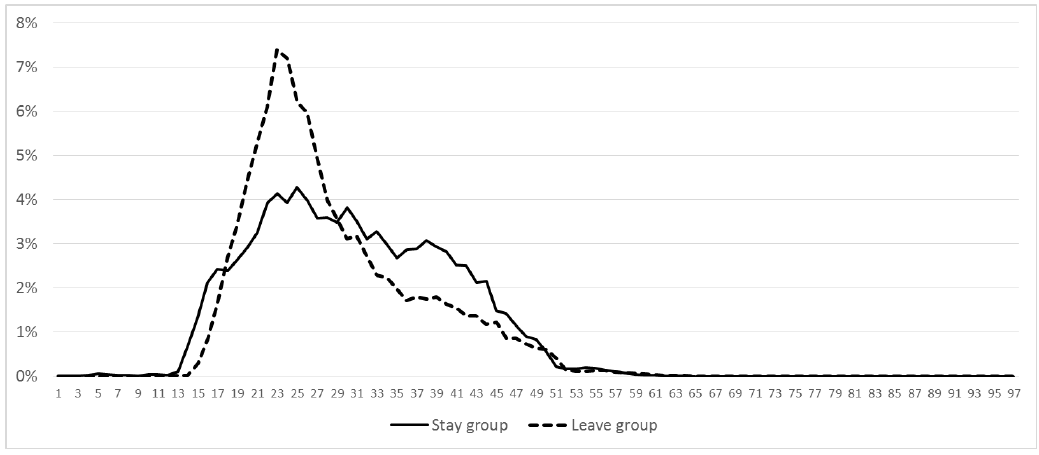
Figure 2. Age and proportion of the floating population.